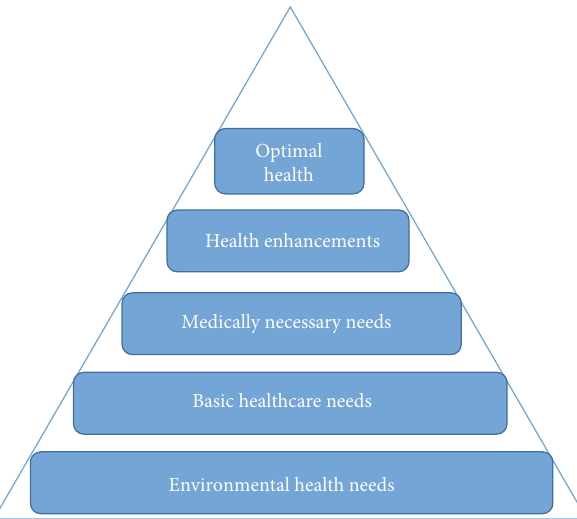
Figure 2: Pyramid of healthcare needs